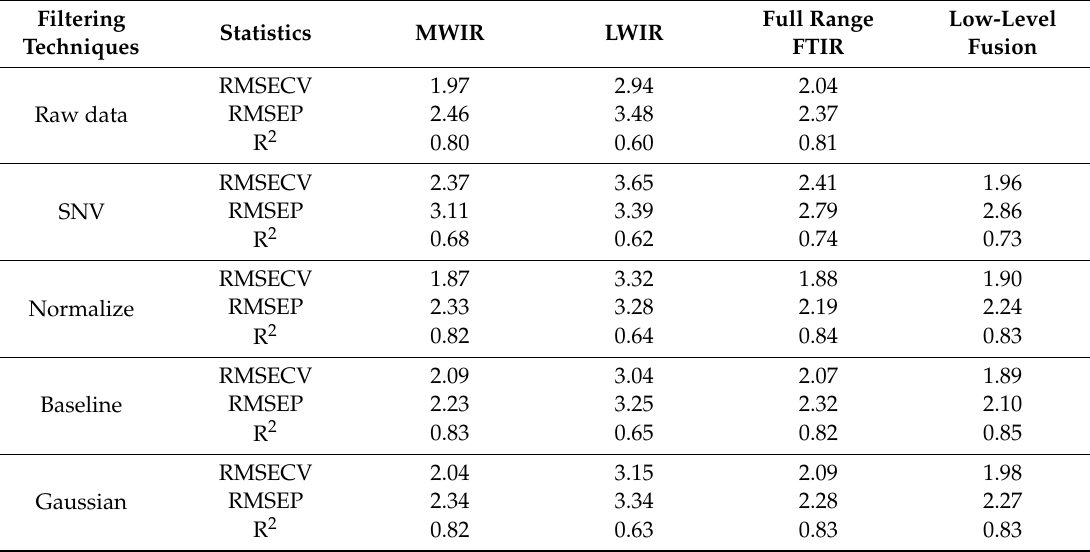
Table 4. Summary statistics of the predictive performances of MWIR, LWIR, full-range FTIR, and low-level data fusion models for the combined Pb–Zn concentration